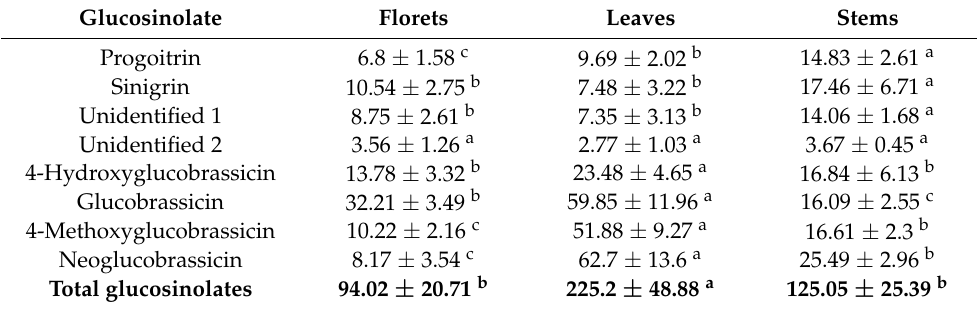
Different letters in a row indicate statistically significant ( p -value < 0.05) differences between the